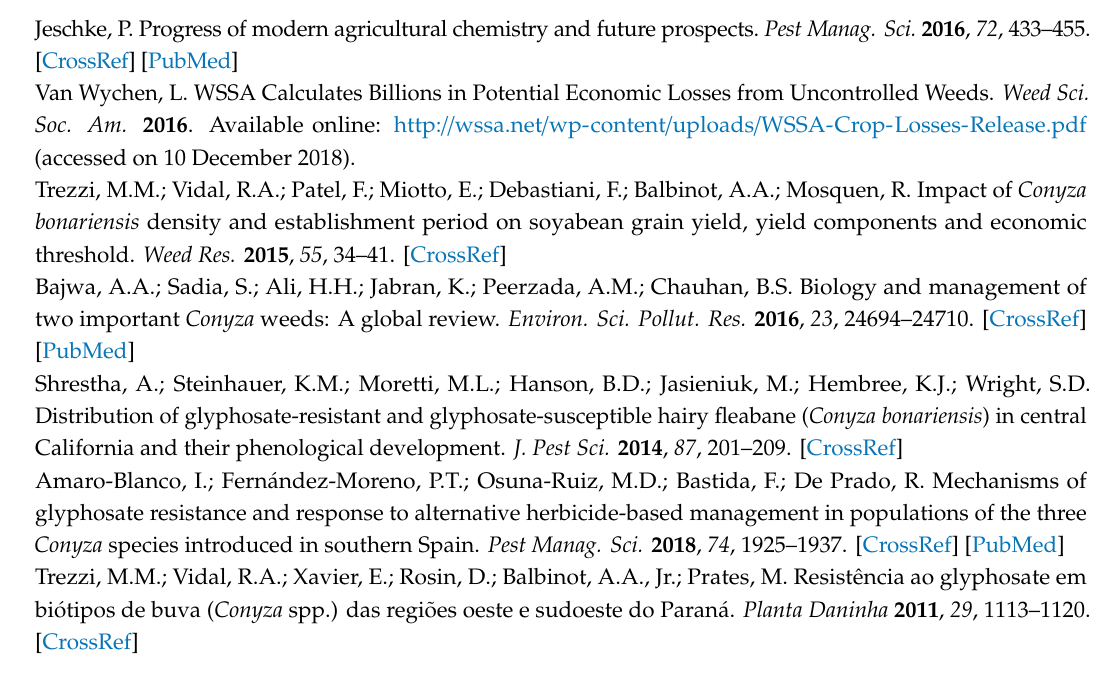
model. The bootstrap consensus tree inferred from 500 replicates is taken to represent the evolutionary history